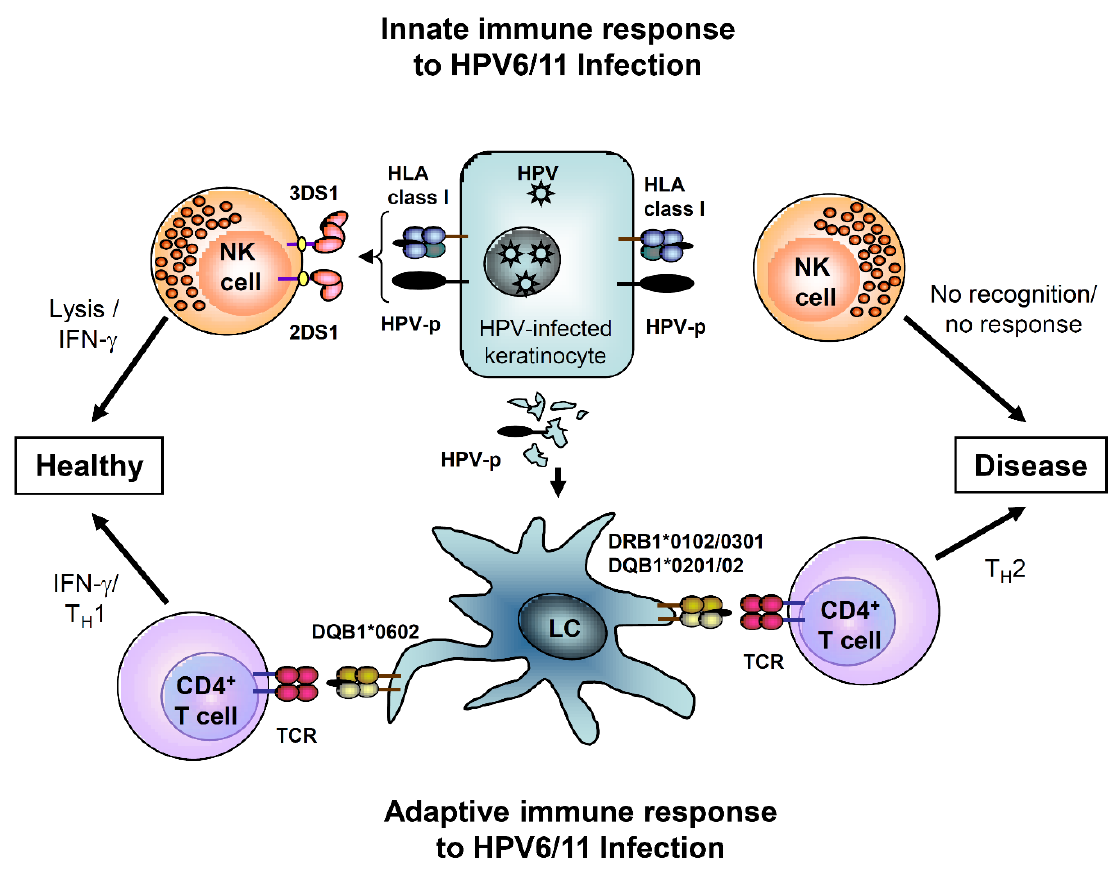
Figure 1. Immune Responses Support Persistent HPV 6/11 infection that Causes Human Papillomaviruses (HPV)-induced Disease. Both the innate and adaptive immune responses to HPV infection are polarized away from effective T H 1-like responses in genital warts and respiratory papillomas, leading to persistent HPV-induced disease. The innate immune response to HPV infection is normally mediated by Natural Killer (NK) cell recognition of activating and inhibited killer cell immunogloublin-like receptor ( KIR ) gene products that recognize reduced human leukocyte antigen (HLA) class I molecules on HPV-infected keratinocytes. Lack of recognition, due to activating haplotype biasing in recurrent respiratory papillomatosis (RRP), results in an infective innate immune response. The adaptive immune response is also polarized by the failure of Langerhans cells to mature and then present peptides to T-cells, which results in altered/impaired Langerhans cell (LC) signaling that results in a T H 2 T-cell bias, which when combined with the lack of NK activity, results in persistent HPV-induced disease. Figure adapted from